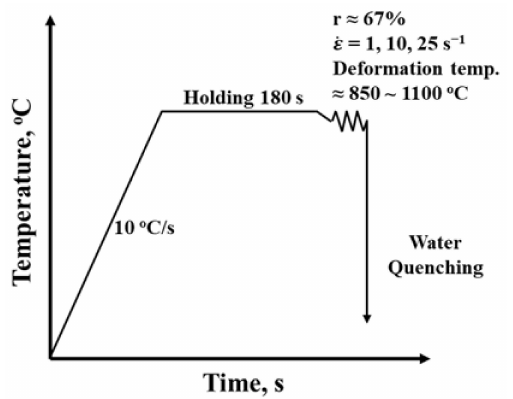
Figure 2. Compression test profile of temperature vs.